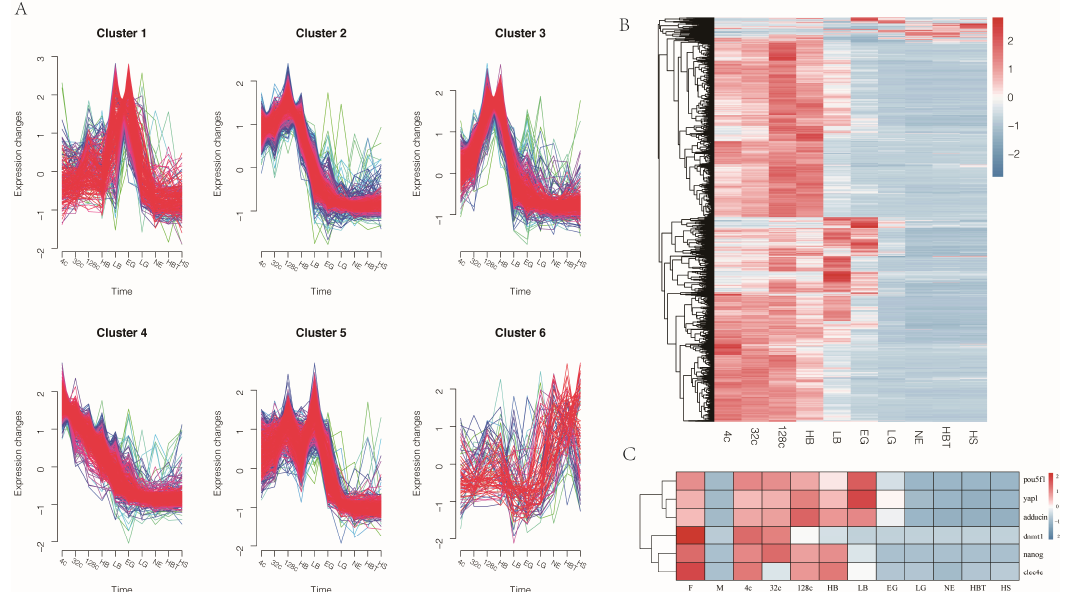
Figure 3. Transcriptome-wide time-series cluster of maternal gene expression profiling. ( A ) Cluster analysis of maternal gene expression based on Mufzz. ( B ) Heatmap shows the expression of the maternal genes in embryo development. ( C ) Heatmaps show expression trends of six maternal-related genes during gamete and embryonic development in RNA-seq data. M: sperm, F: egg, 4c: 4-cell, 32c: 32-cell, 128c: 128-cell, HB: high blastula, LB: low blastula, EG: early gastrula, LG: late gastrula, NE: neurula, HBT: heart-beating, HS: hatching stage.